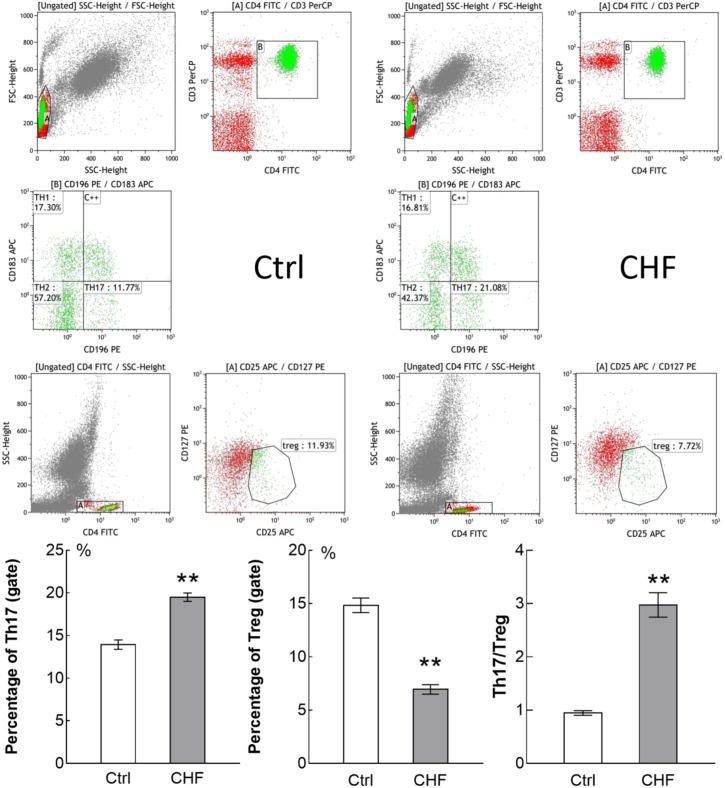
Flow cytometry assay showed the percentage of Th17 cells and Treg cells in CHF patients (25 cases) compared to control subjects (15 cases). The original flow cytometry plots of the two groups is displayed above, and histogram comparison of Th17, Treg cells and the ratio of Th17/Treg is displayed below. Th17 cells in CHF group was significantly higher than in control group (∗∗P < 0.01), while Treg cells in the CHF group was significantly lower than in control group (∗∗P < 0.01); thereby the ratio of Th17/Treg in the CHF group was significantly higher than that in the control group (by ∼3-fold, ∗∗P < 0.01).